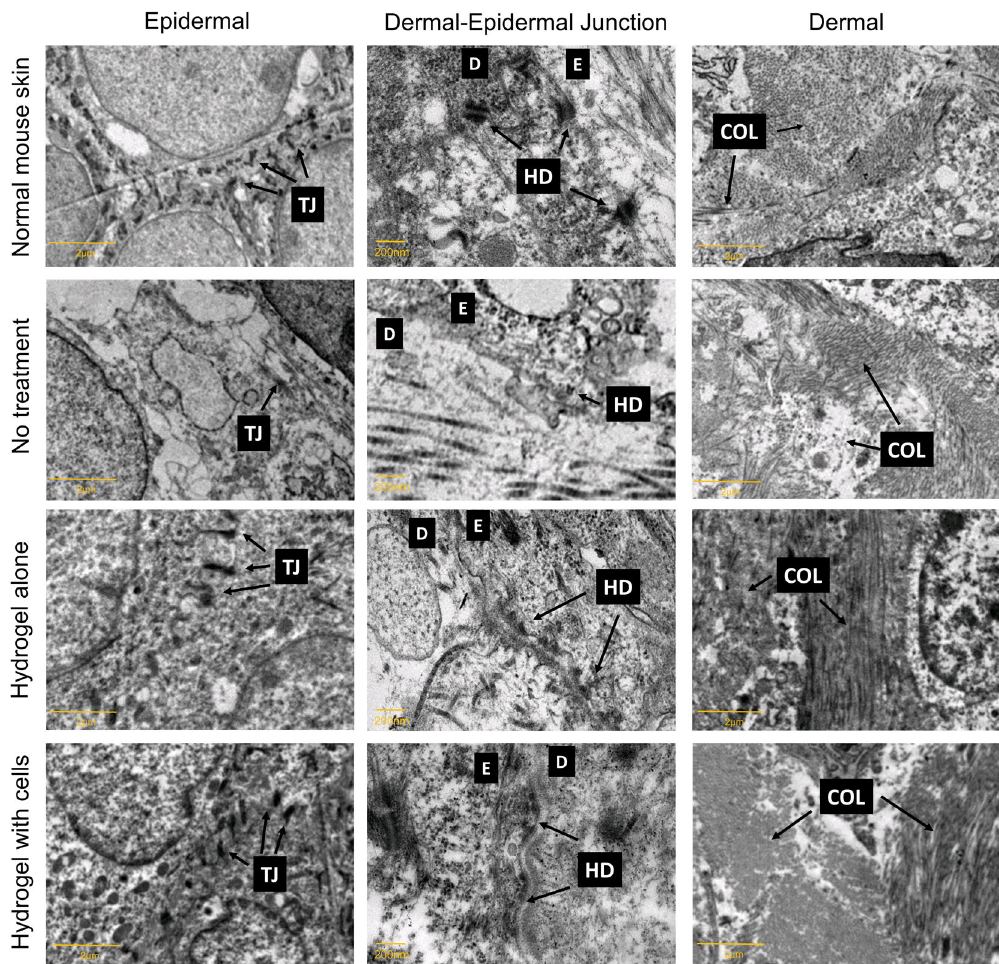
Figure 7. Transmission electron micrographs of the epidermal (4200 × magnification), dermal-epidermal junction (43,000 × magnification), and dermal structure (4200 × magnification) for the different treatment groups. TJ refers to tight junction; HD refers to hemidesmosome; E refers to the epidermis layer; D refers to the dermis layer; COL refers to collagen fibers. Arrow for COL points to cross section and longitudinal